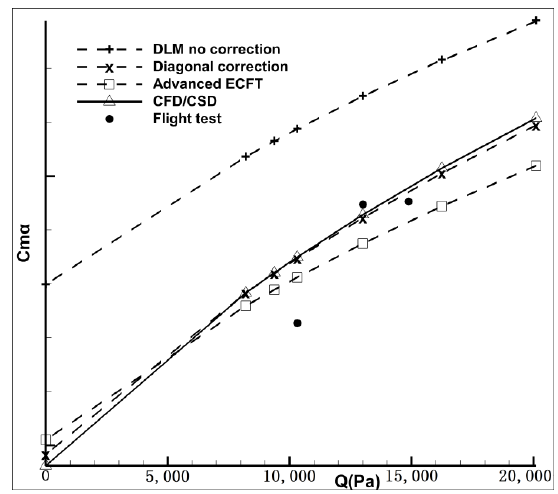
Figure 13. Elastic C m α at different dynamic pressures.